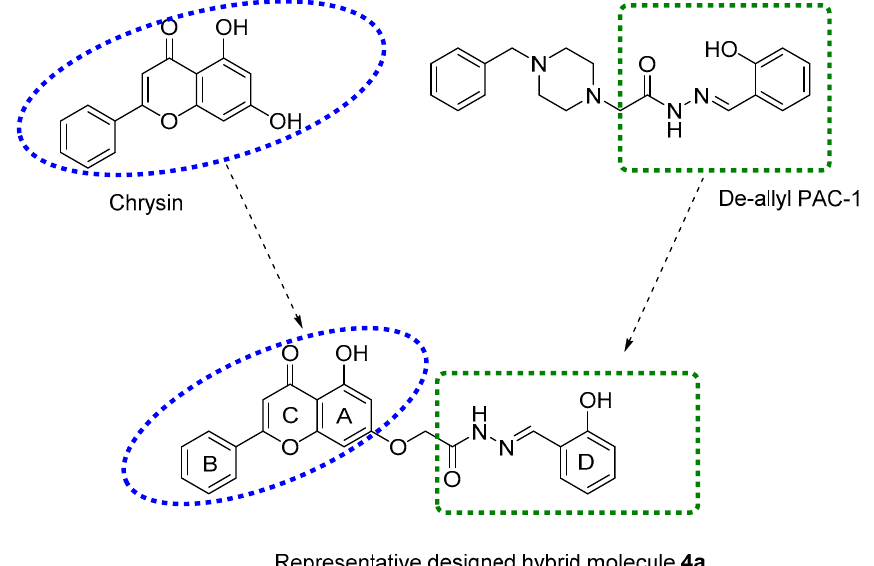
Figure 1. Chemical structures of chrysin, de-allyl PAC-1, and a representative designed hybrid molecule 4a.